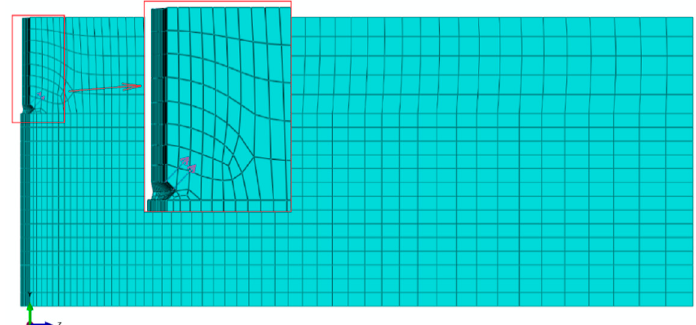
Figure 3. The model discretization method—the modelled quadrant.